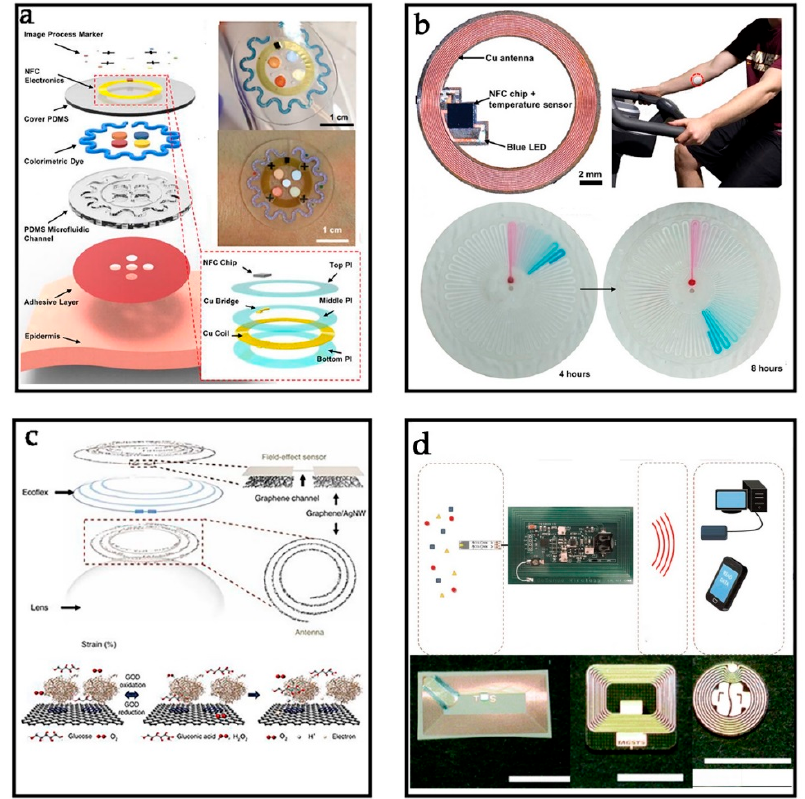
Figure 4. Applications for Biochemical signals monitoring: ( a ) Schematic illustration of an epidermal microfluidic sweat monitoring device and an enlarged image of the integrated near-field communication (NFC) system. Reprinted with permission from ref. [60]. ( b ) The NFC electronics consist of a magnetic loop antenna, NFC chip with an on-board temperature sensor, LED, and passive components. Reprinted with permission from ref. [22]. ( c ) Schematic of the wearable contact lens sensor, integrating the glucose sensor and intraocular pressure sensor. Reprinted with permission from ref. [102]. ( d ) Tears analysis with paper-based microfluidic system. Reprinted with permission from ref. [103].